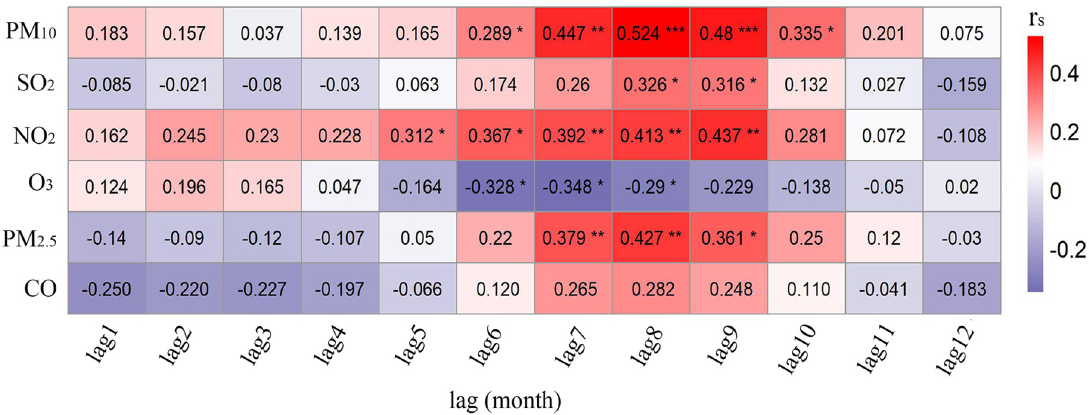
Fig 5. Spearman ranks correlation coefficients between the PTB cases and air pollutants with a lag of 1 to 12 months. Notes � : P < 0.05 �� : P < 0.01 ��� : P <